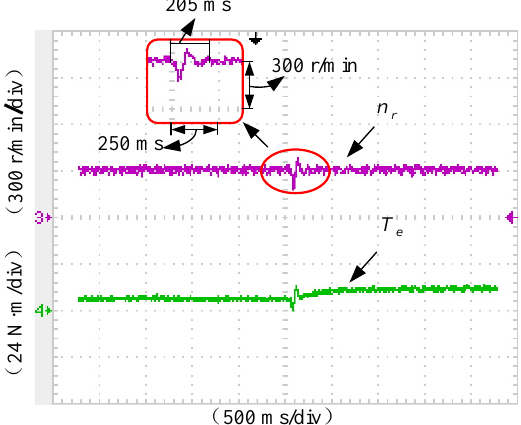
Figure 19. Dynamic performance of RDTC without TIBC ( P = 7.2, I = 0.96).